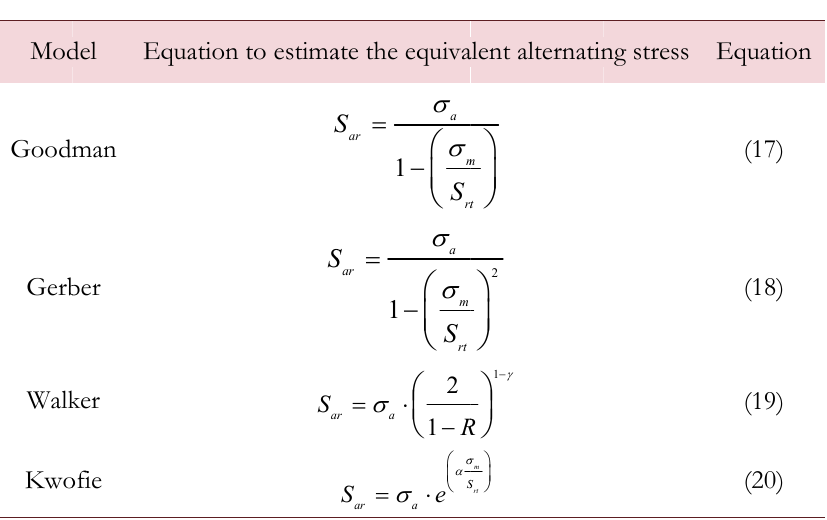
Table 4: Equ uations used to rnating of the Kwofi